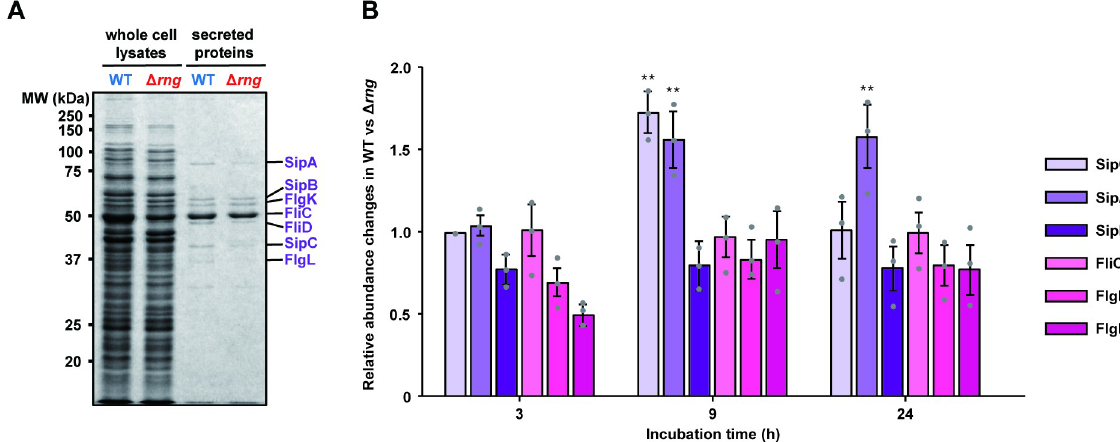
Fig 2. Differentially expressed proteins in WT and Δ rng strains. (A) SDS-PAGE analysis of T3SS effector proteins and flagellar proteins in the whole-cell lysates and concentrated supernatants of S . Typhimurium strains (WT and Δ rng ). Seven specific protein bands (SipA, SipB, FlgK, FliC, FliD, SipC, and FlgL denoted on the right of the gel) were identified by in-gel digestion and tandem mass spectrometry, as described in the Materials and Methods. (B) The relative abundance of T3SS effector proteins and flagellar proteins determined from the protein expression profiles in the supernatants of WT and Δ rng strains, as described in S3 Fig. Relative abundance of these proteins was measured by densitometric analysis of the band intensities of these proteins. For this analysis, the relative abundance of FliC/FliD proteins was set to 1. Statistically significant differences in relative SipA and SipC levels between WT and Δ rng cells were compared to the FliC/FliD levels by two-tailed t -tests. �� P < 0.01.